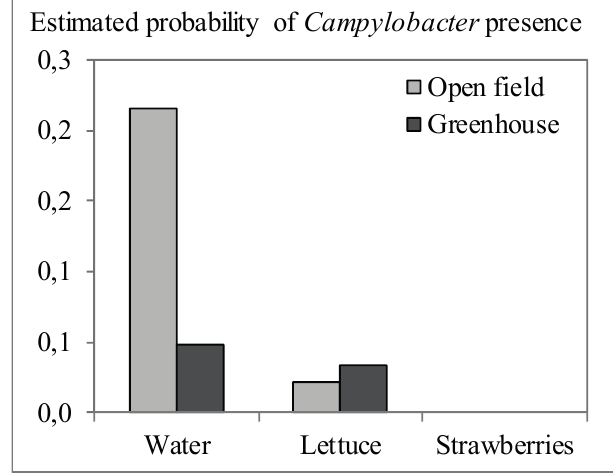
Figure 4. Effect of farm type and sample type on the estimated probability of Campylobacter presence by multiple logistic regression (Table 3), exemplified by the country Norway and the practice of not storing irrigation water in open